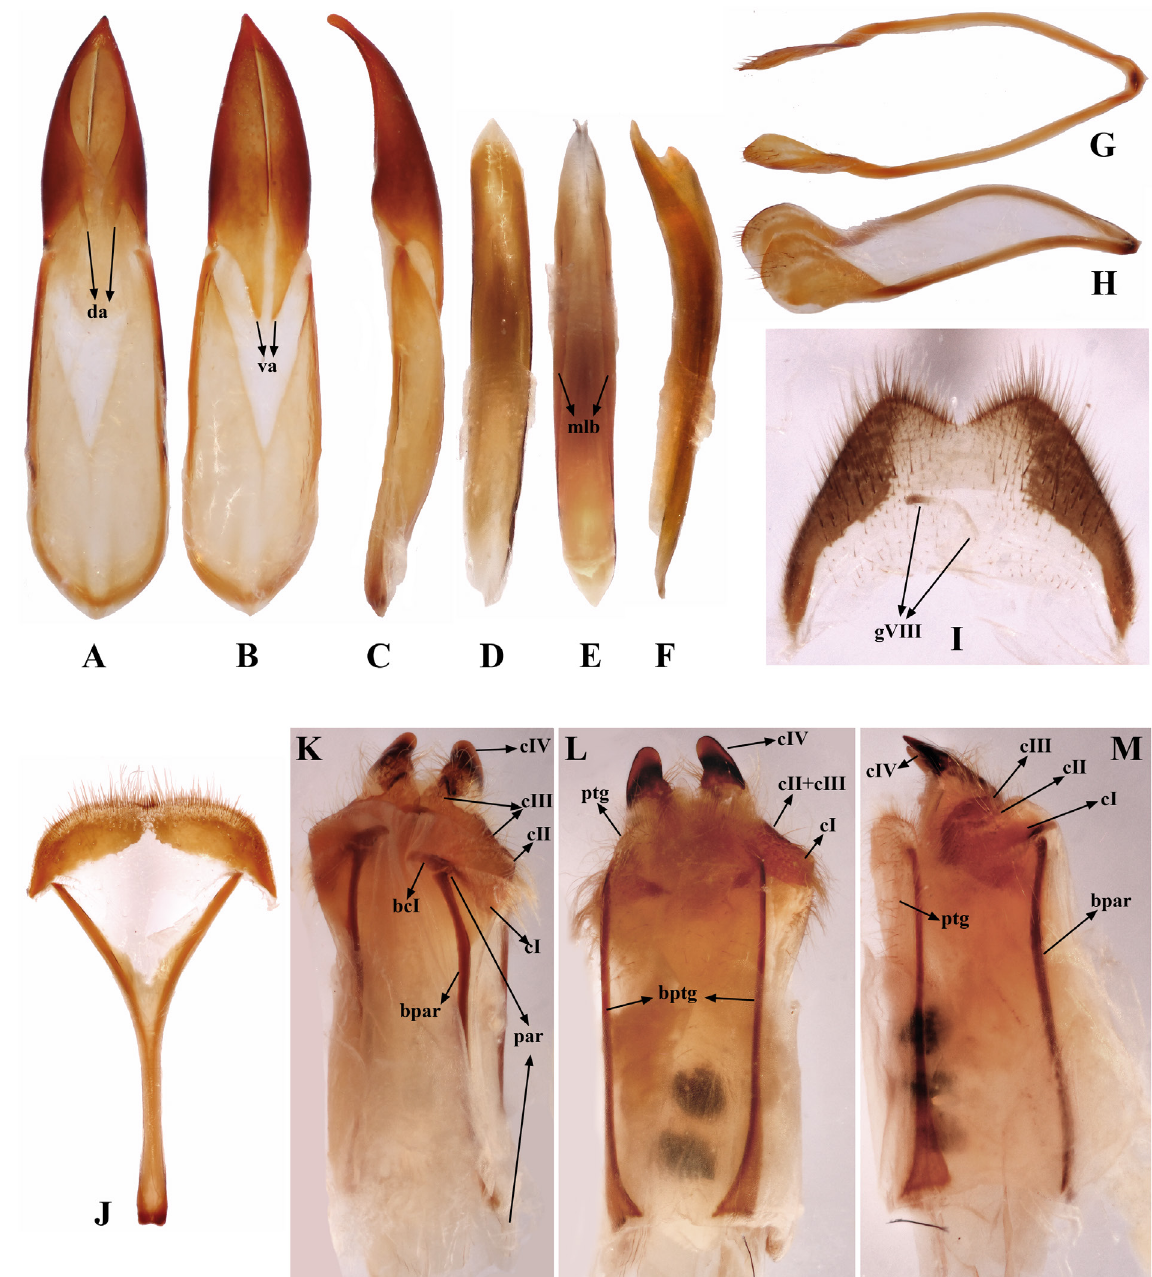
Fig. 21. Platyope grumi (Semenov, 1893) , genitalia (ZIN). A . Tegmen of aedeagus, ventrally. B . Ditto, dorsally. C . Ditto, laterally. D . Median lobe, ventrally. E . Ditto, dorsally. F . Ditto, laterally. G . Spiculum gastrale, ventrally. H . Ditto, ventro-lateral view. I . ♂, inner sternite VIII. J . ♀, inner sternite VIII and spiculum ventrale. K . ♀, paralectotype?, ovipositor, ventrally. L . Ditto, dorsally. M . Ditto, laterally. Not to scale. Abbreviations: see Material and